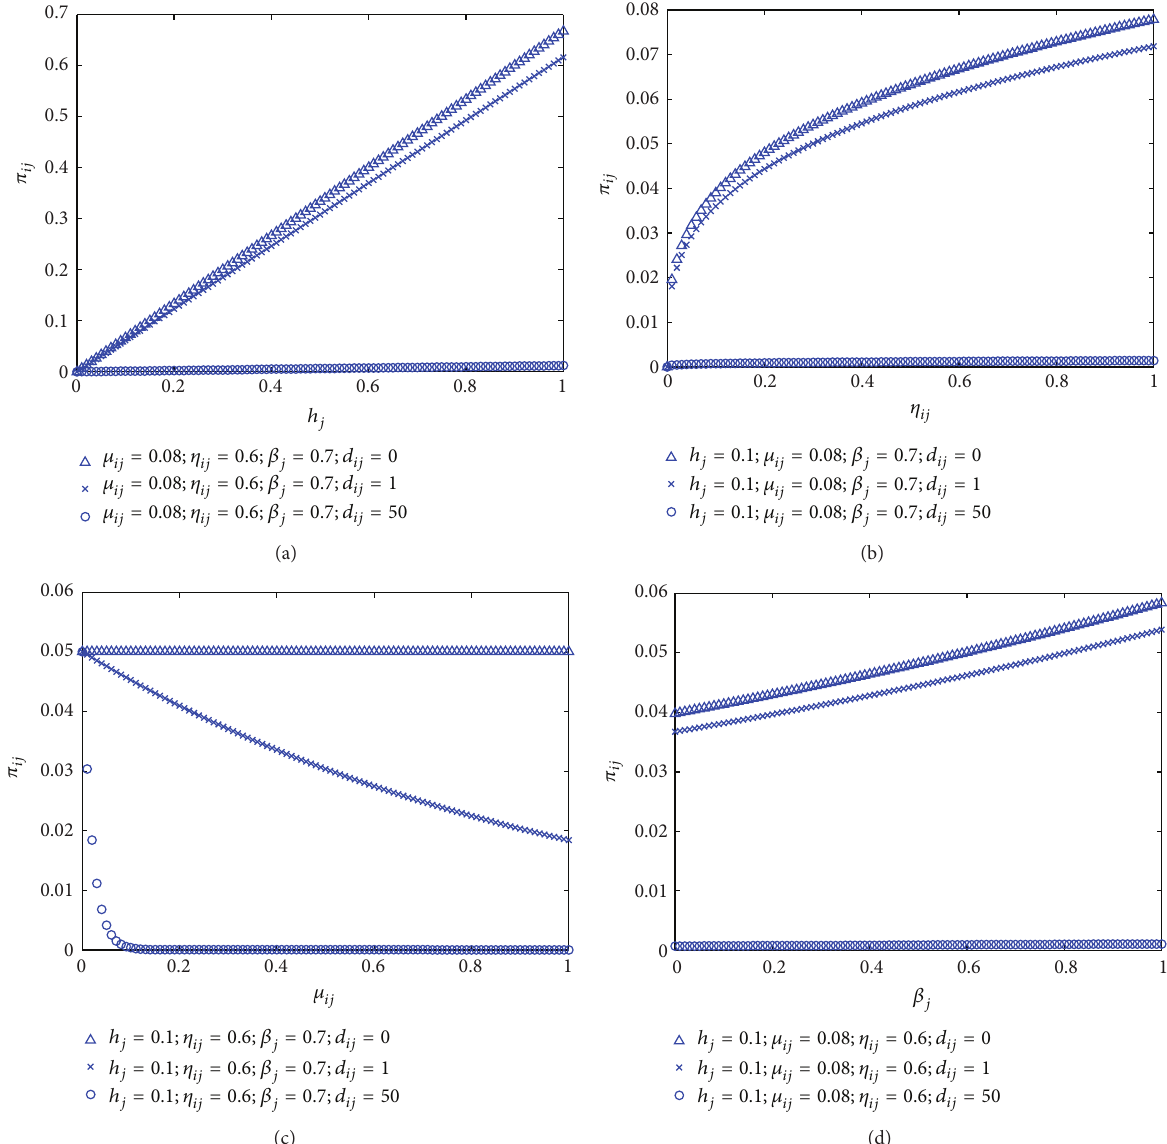
Figure 3: Effect of the concentration of credit risk of investor ℎ 𝑗 , the ability of credit risk transfer of banks 𝜂 𝑖𝑗 , nonlinear coupling 𝜇 𝑖𝑗 between banks and investors, and the appetite for risk of investors 𝛽 𝑗 on credit risk contagion in the CRT network.